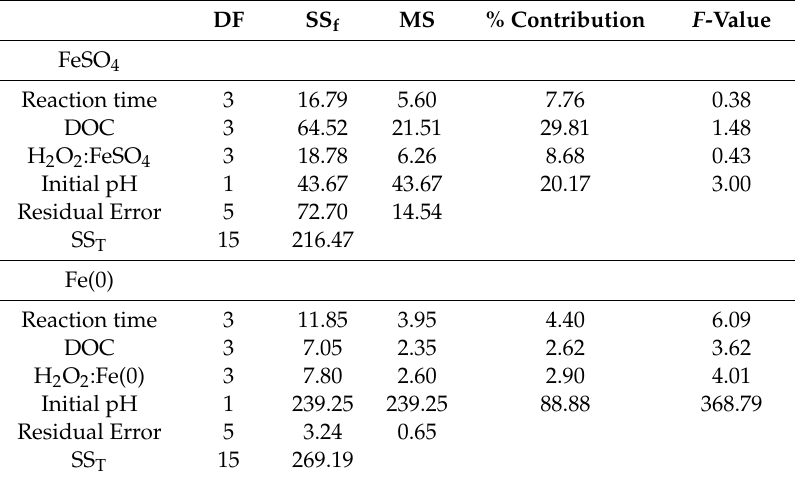
Table 8. ANOVA analysis of SN